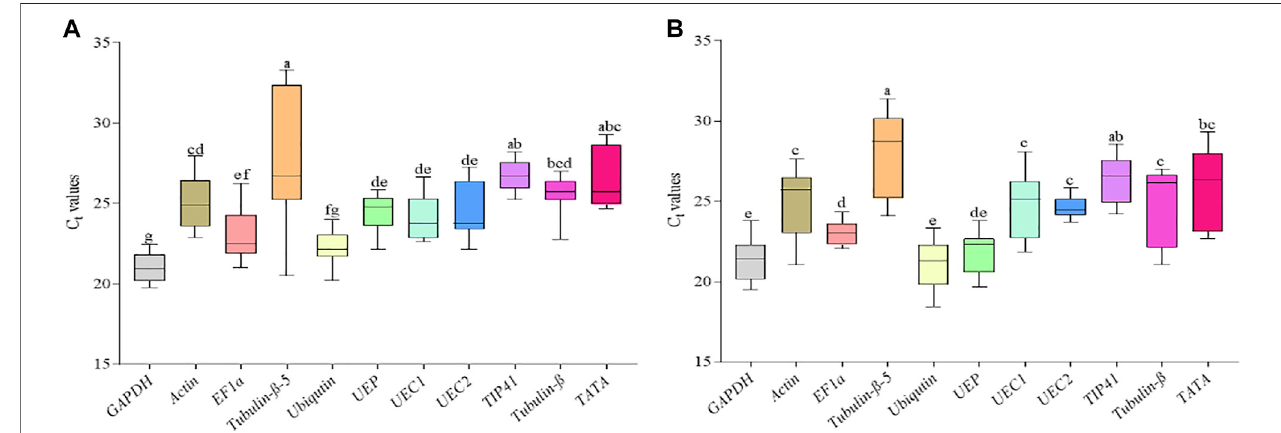
FIGURE 3 | Threshold cycle (C t ) of the 11 candidate reference genes in the aboveground parts of young and matured R. delavayi plant. (A) Young plant (matured leaves (ML) +stem tips (STM)+ under drought stress (DS) condition. (B) Maturedplant (ML +STM + fl ower buds (FB)). Average ofthe2 years (2017 and 2018sampling periods). Lower and upper lines on the box represent the minimum and maximum C t , respectively. The lower and upper parts of the box represent 25 and 75% percentile, respectively, and the line in the middle of the box represents mean Cq for each gene. Boxes with a common alphabet indicate no signi fi cant difference ( p > 0.05), while those with no common alphabet indicate signi fi cant difference ( p < 0.05) with Post hoc mean separation by Duncan ’ s Multiple Range